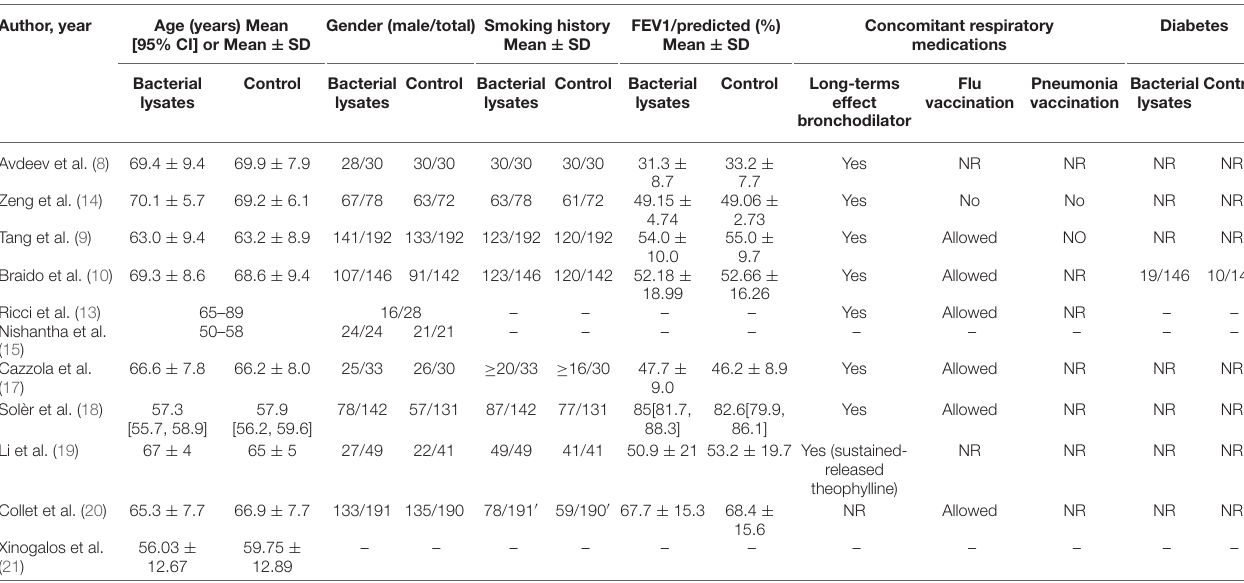
TABLE 2 | The characteristics of the included